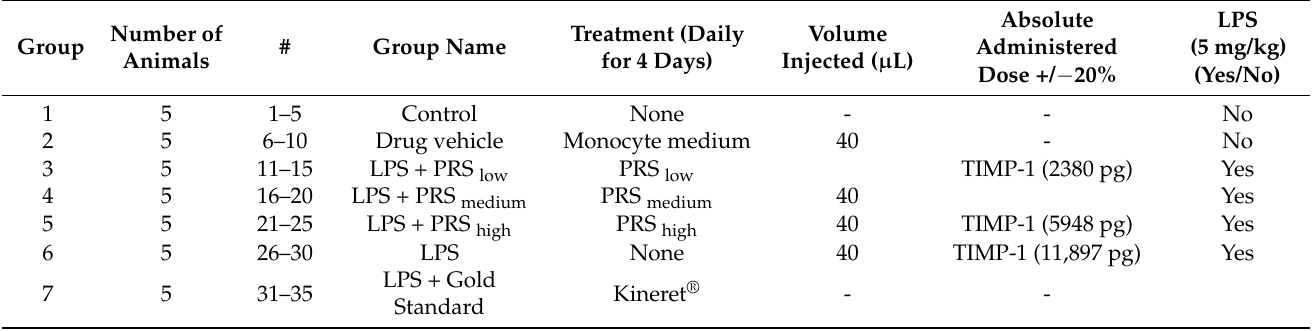
Table 3. Description of the groups of animals, LPS, and administered treatment. In the case of PRS CK STORM, 5 representative cytokines/growth factors were